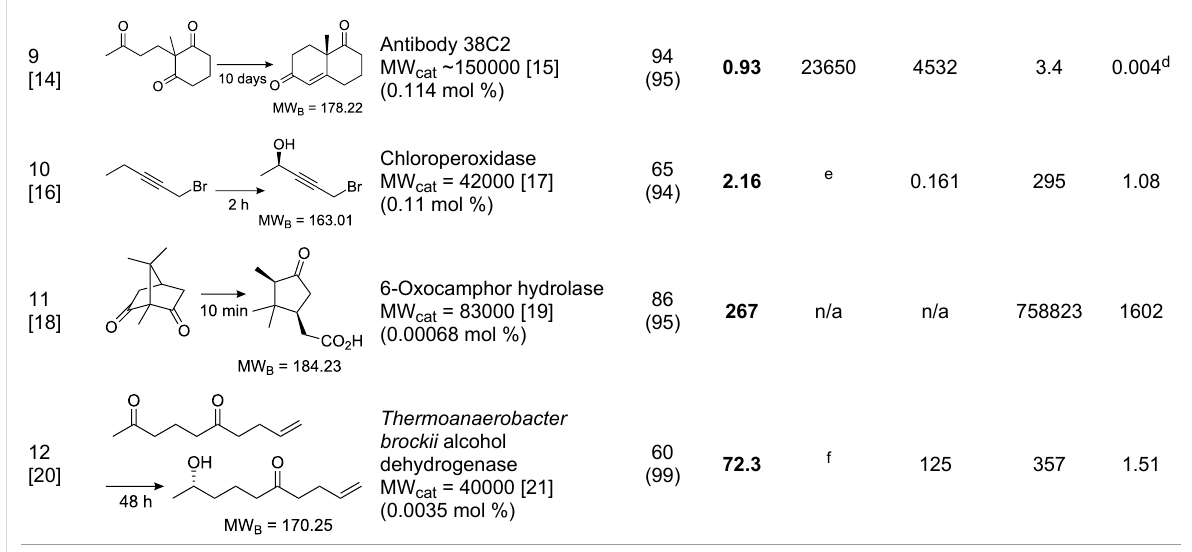
Table 1: Calculation of ACE for various catalytic asymmetric transformations.